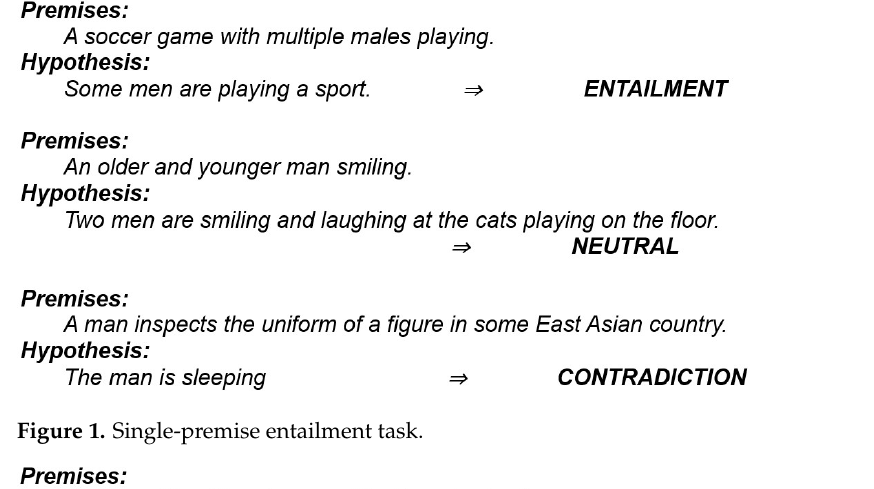
Figure 1. Single-premise entailment task.